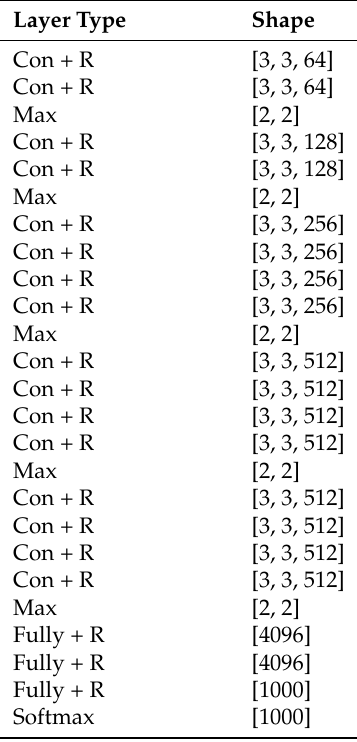
Table 1. Model of VGG-19 [28]. “Con" is a convolution layer. “R" is the ReLU activation. “Max" is a Max pooling. “Fully" is a fully connected